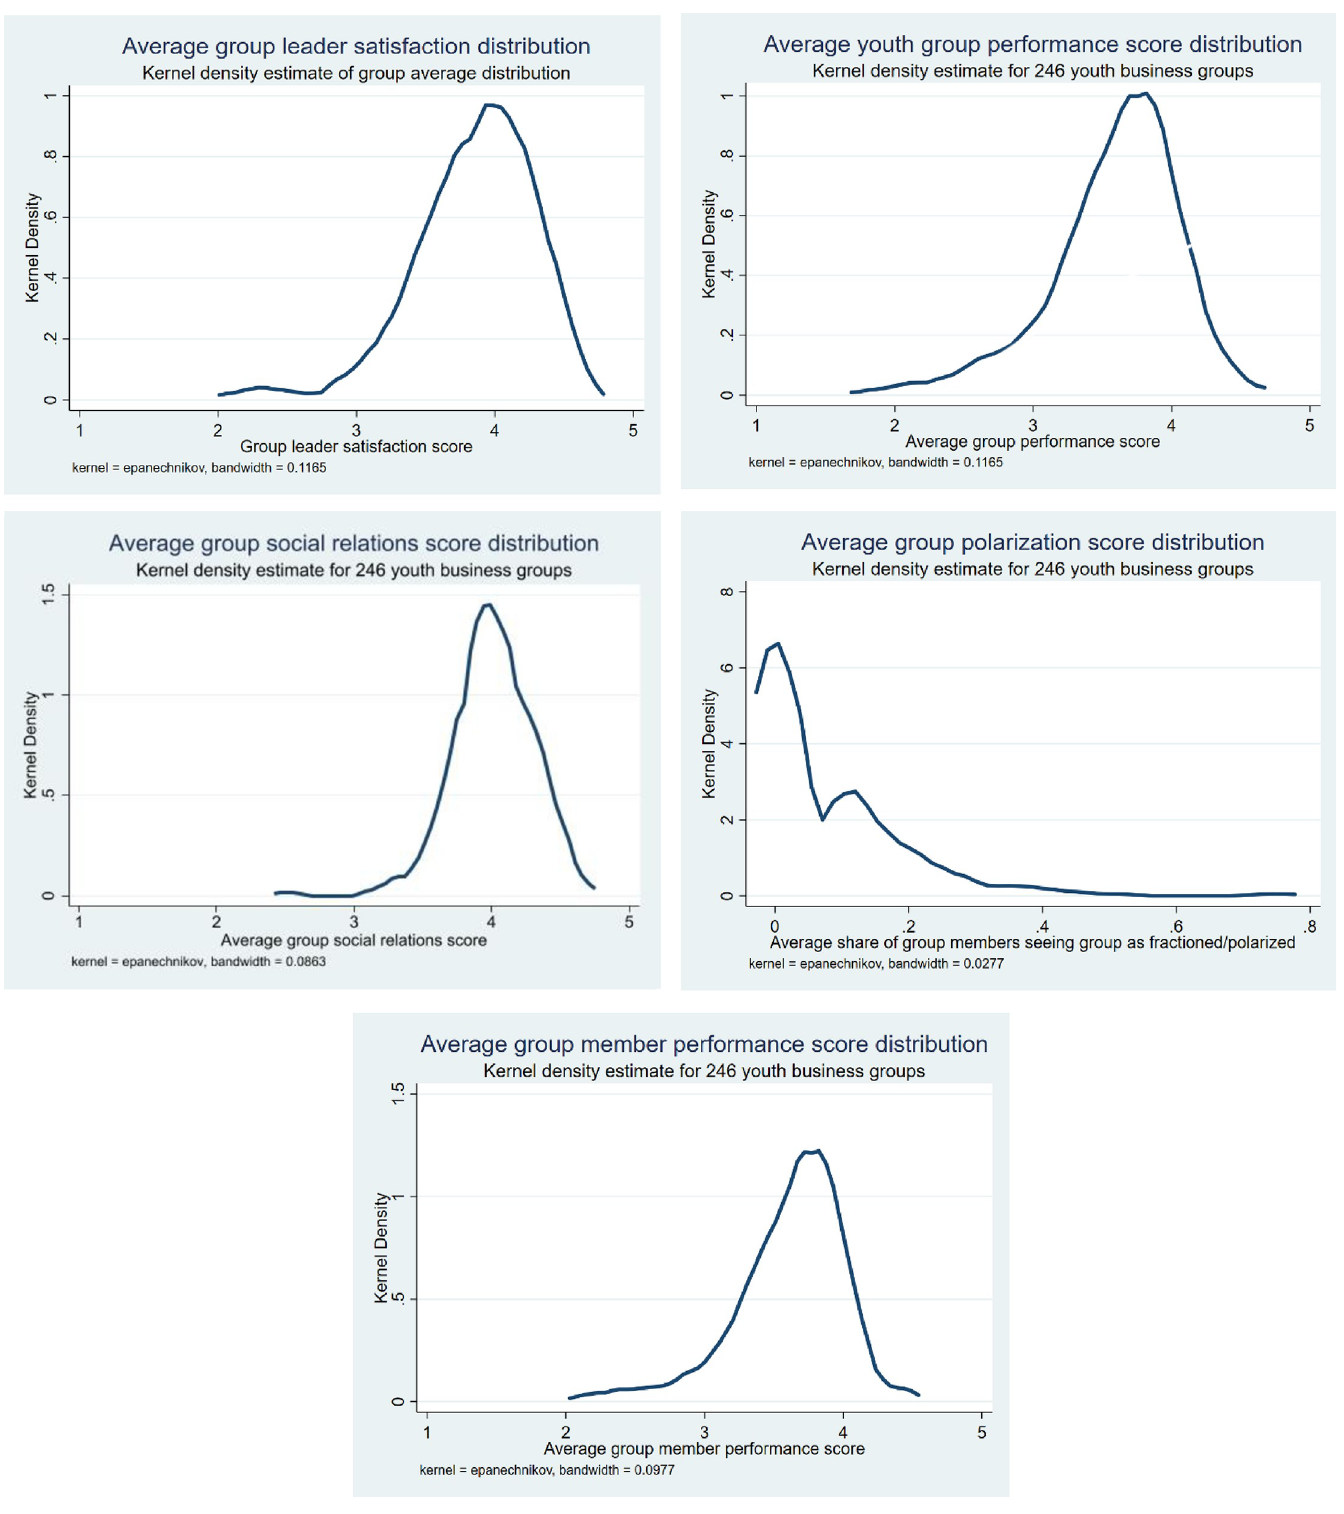
Fig 5. a. Average group leader satisfaction score distributions. b. Average youth group performance score distributions. c. Average group social relations score distributions. d. Average group polarization score distributions. e. Average group member performance score distributions.